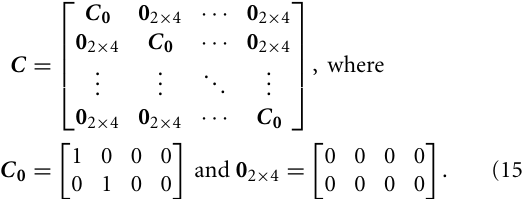
location with and without aggregation at time t = 8. Individu- als are represented as black dots and dense regions are shown as shaped cells,according to the legend. The predicted outcome from UAVs has two missed predictions, which have dashed cell bound- aries. The predicted outcome from UAVs has two missed predic- tions, which have dashed cell boundaries. Such missed